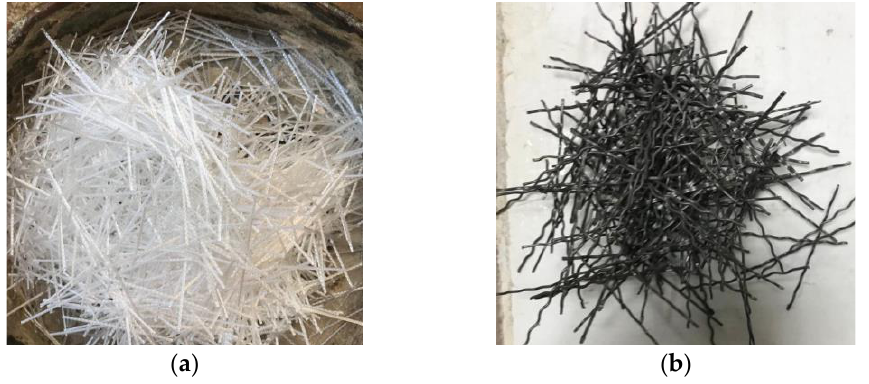
Figure 1. Shape of ( a ) polypropylene fiber and ( b ) steel fiber.